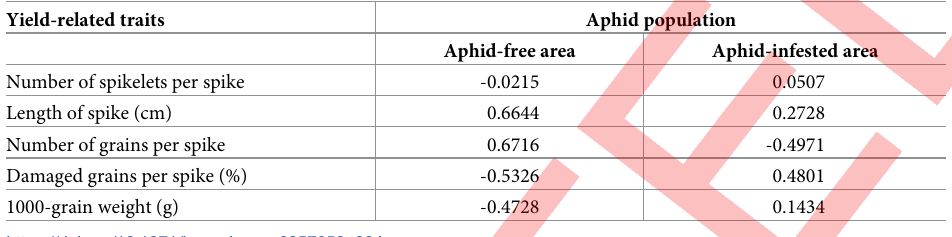
Table 4. Correlation analysis of aphid population with yield related components in aphid free and aphid infested areas.